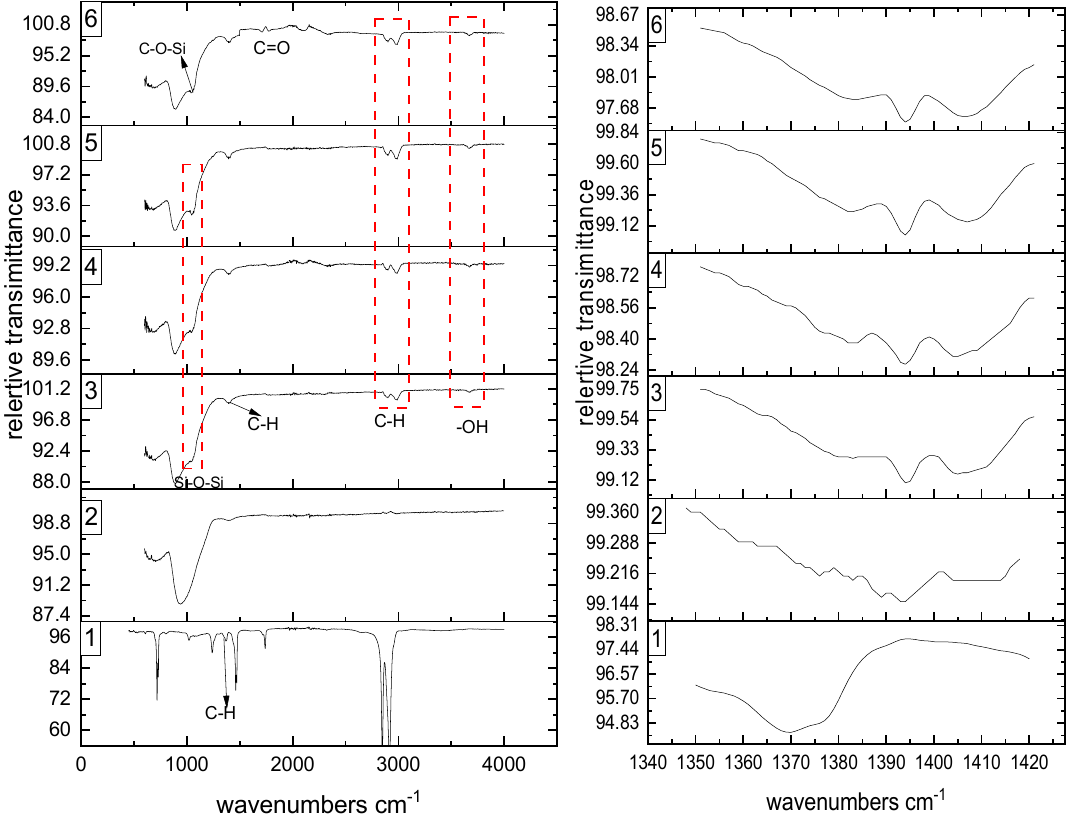
Figure 11. FT-IR spectrum (left) and normalized FTIR spectra in the C-H stretching region (right) of (1) pure PE-g-PS and PE-g-PS-based composites with (2) untreated glass fiber; (3) 1,6 bis; (4) 3-MPS; (5) TES; (6) PP-g-MA.